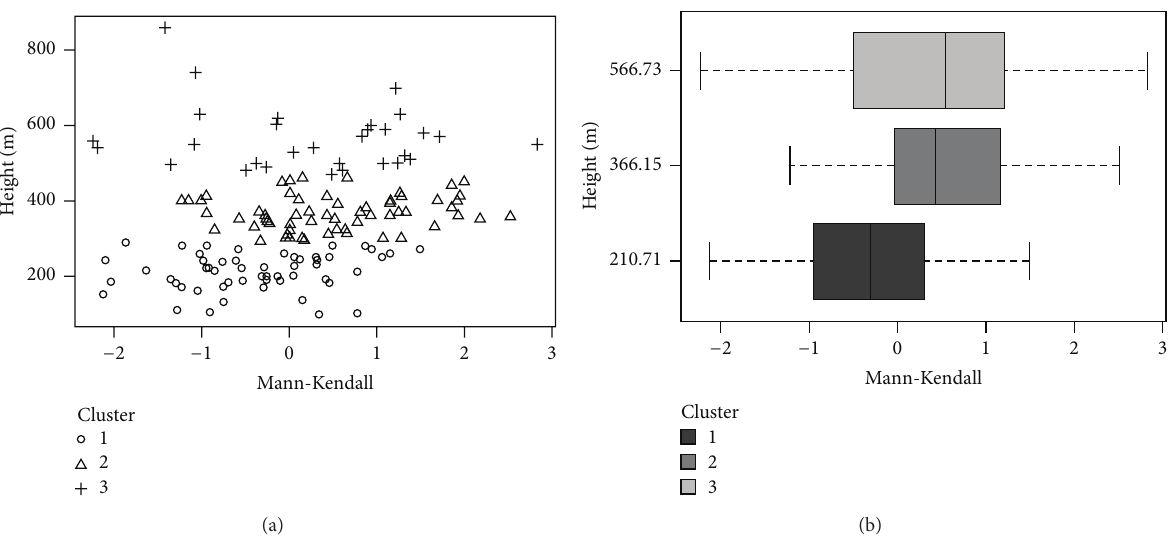
Figure 5: (a) Graphic representation of the Mann-Kendall test values for each one of the altitudes at which the hailpads are installed. (b) Boxplot of the three cluster resultants from the 𝑘 -means cluster analysis. We can see the minimum and maximum values, the median and the first and third quartile for each cluster.